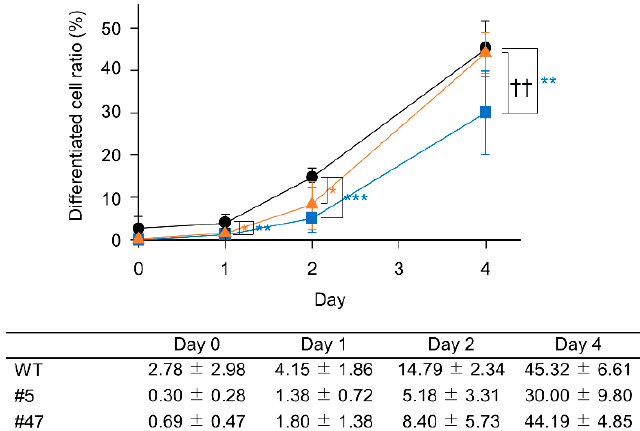
Figure 4. Time course of differentiated cell ratio. The number of differentiated cells relative to the total number of cells following all-trans retinoic acid (ATRA) treatment is shown (HL-60, circle; #5, square; #47, triangle). Each point represents the mean ± standard deviation of three performed experiments. Statistically significant differences between AK2 knock-out cells and HL-60 (* p < 0.05; ** p < 0.01; *** p < 0.001), and between AK2 knock-out #5 and #47 cells (†† p < 0.01).